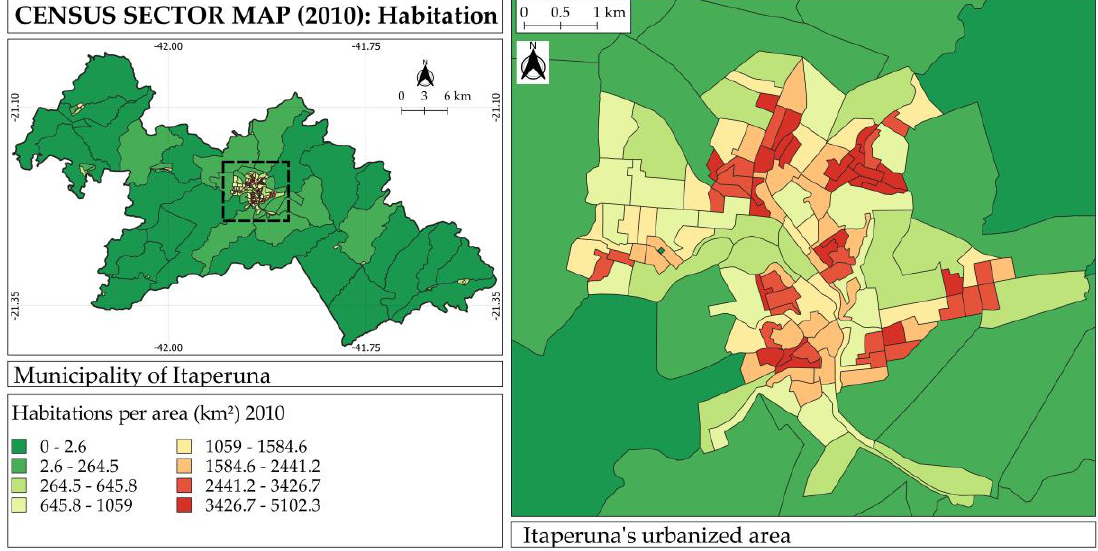
Figure 9. Census sector map of the municipality of Itaperuna: habitations per area released in 2010 [90].